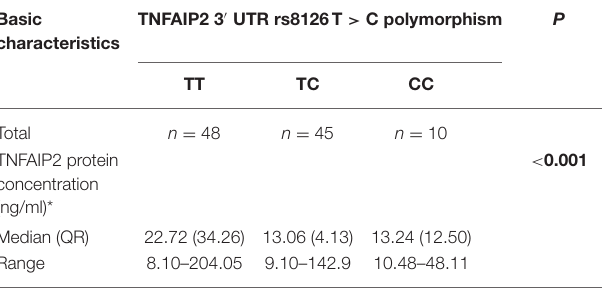
TABLE 12 | The correlation between TNFAIP2 3 ′ UTR rs8126T > C polymorphism and TNFAIP2 protein